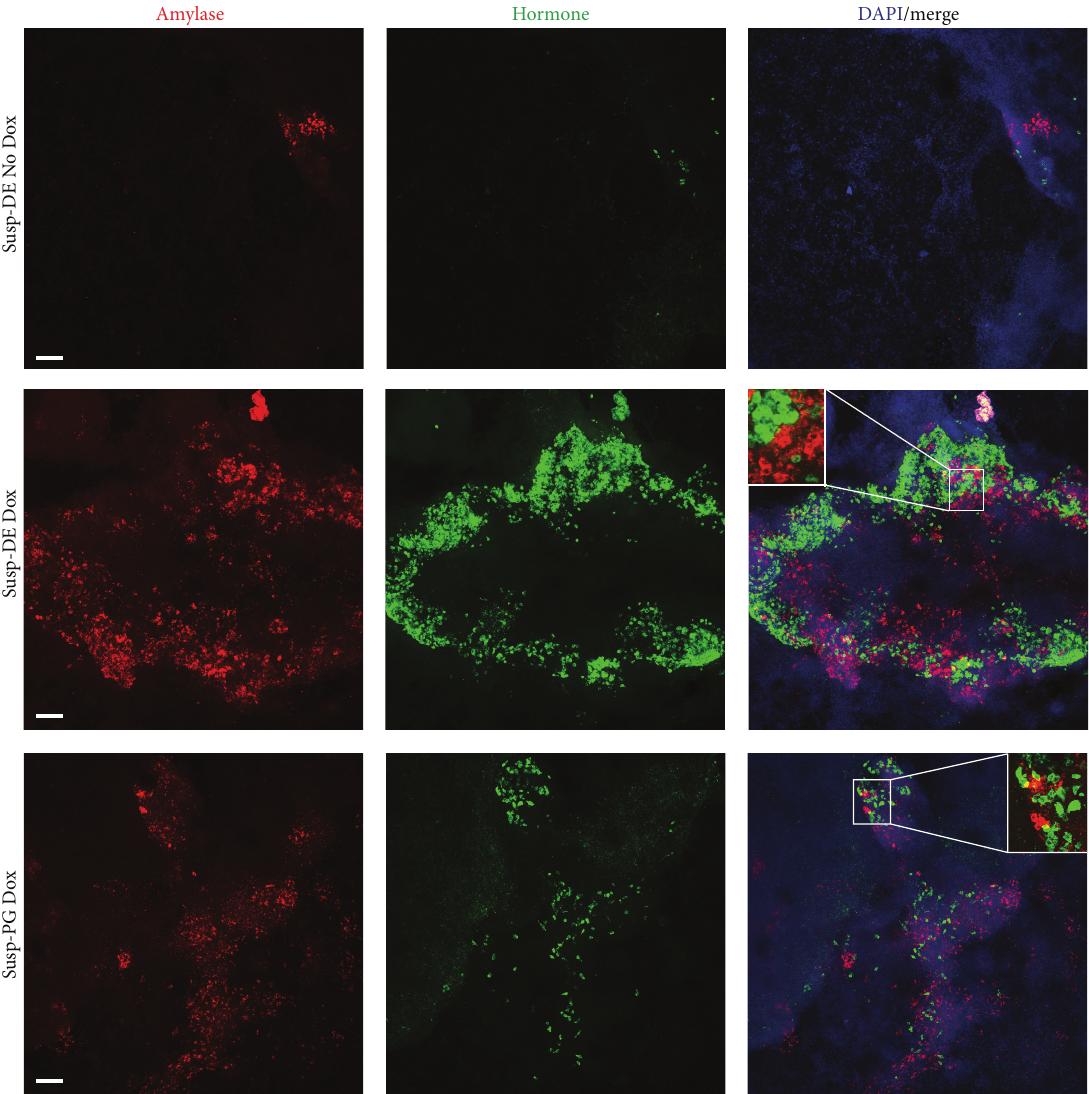
Figure 7: Cultures that were in suspension during either DE or PG stage when induced with PTF1a showed enhanced differentiation to pancreatic cell types. Confocal Z-stacks images at low magnification shown along with DAPI to demonstrate the extent of differentiation between conditions. Susp-DE Dox and Susp-PG Dox cultures had large numbers of Amy + and Horm + cells compared to No Dox cultures and attachment cultures (data not shown). Susp-DE Dox cultures had more Amy + and Horm + cells than Susp-PG Dox cultures. High magnification insets are shown to indicate cytoplasmic staining of hormones and amylase. Scale bars, 50 𝜇 m.